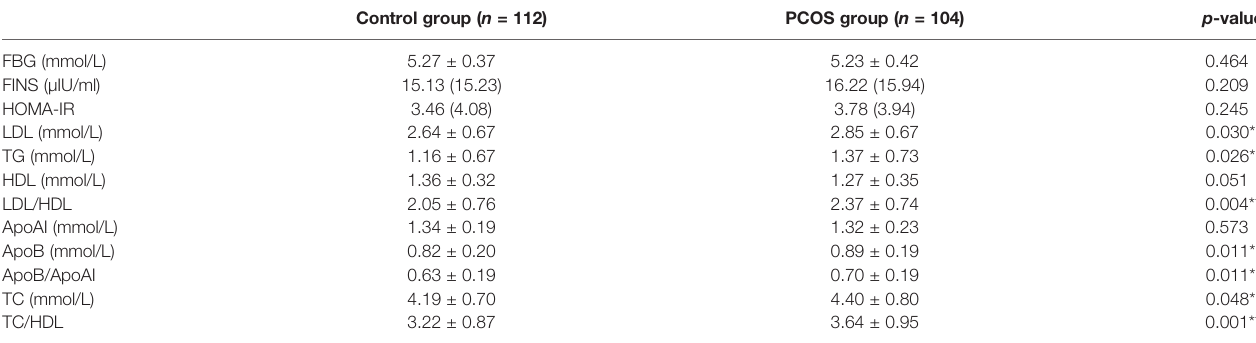
FBG, free blood-glucose; FINS, fasting insulin; LDL, low-density lipoprotein; TG, triglyceride; HDL, high-density lipoprotein; ApoAI, apolipoprotein AI; ApoB, apolipoprotein B; TC, total cholesterol; HOMA-IR = FBG ＊ FINS/22.5. *p < 0.05, **p <